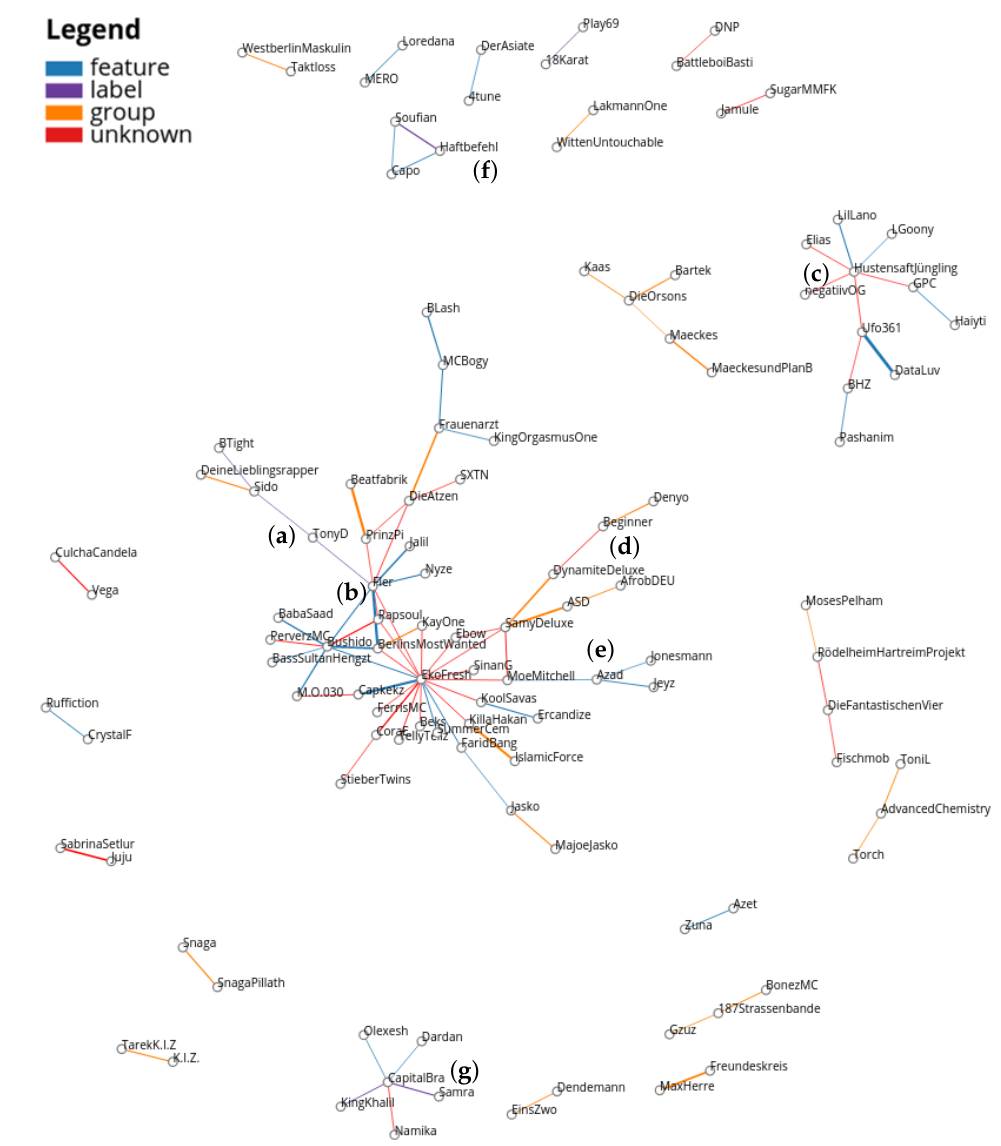
Figure 2. An excerpt of the similarity network of German rap artists based on the most similar lines in their lyrics. Label and collaboration partners tend to be connected. ( a ) previos members of the label “Aggro Berlin” and the rap crew “Die Sekte”, ( b ) previous members of “Ersguterjunge” and “Berlins Most Wanted”, ( c ) Hustensaft Jüngling and some feature partners, ( d ) Hamburg-based artists, ( e , f ) Frankfurt-based artists, ( g ) Capital Bra with label and feature